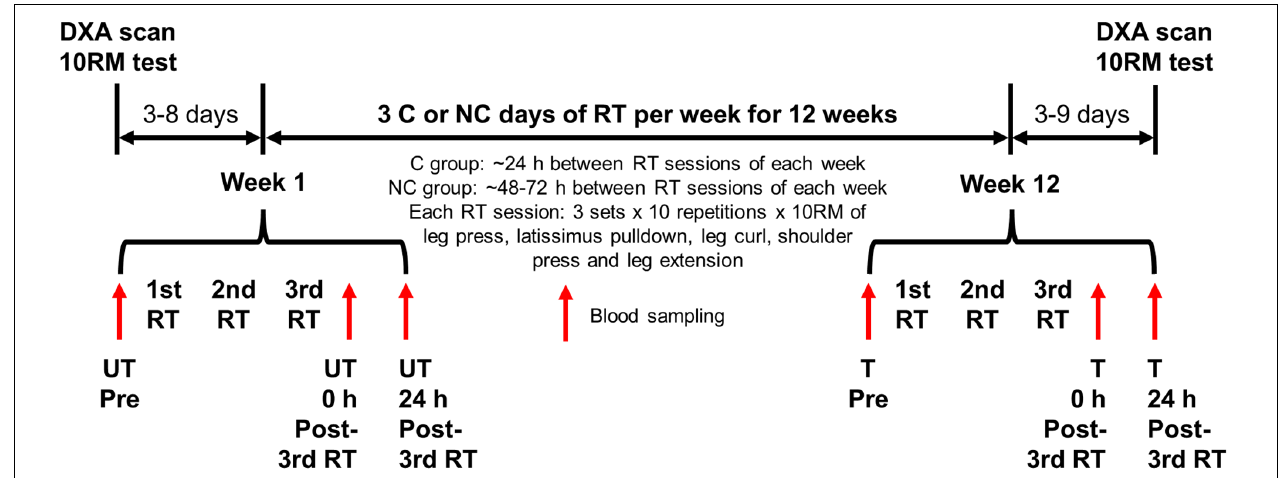
FIGURE 1 | Experimental design. Participants were randomly assigned to either three consecutive (C) or non-consecutive (NC) days of resistance training (RT) per week for 12 weeks, and completed the same procedures except for the recovery period between RT sessions of each week. Blood samples were collected at weeks 1 and 12 of the RT as indicated. DXA, dual-energy X-ray absorptiometry; 10RM, 10-repetition maximum; UT, untrained; T, trained.